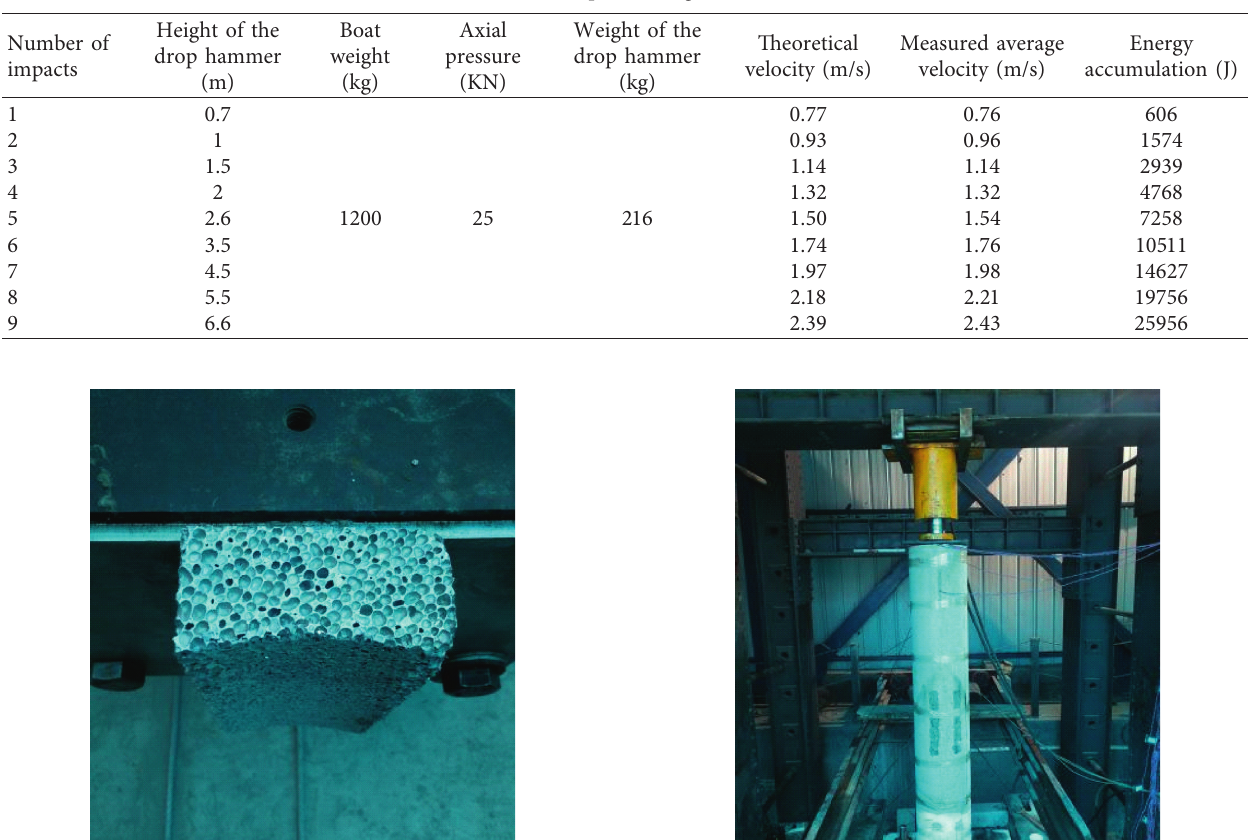
Figure 4: Ultrahigh drop hammer impact test system (unit: mm). Table 4: Impact testing scheme.